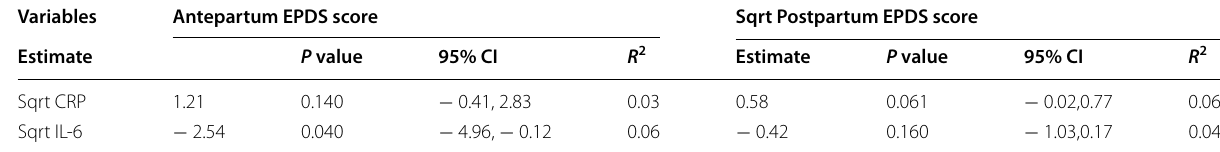
Table 4 Linear regression analysis examining association between biomarkers and EPDS scores